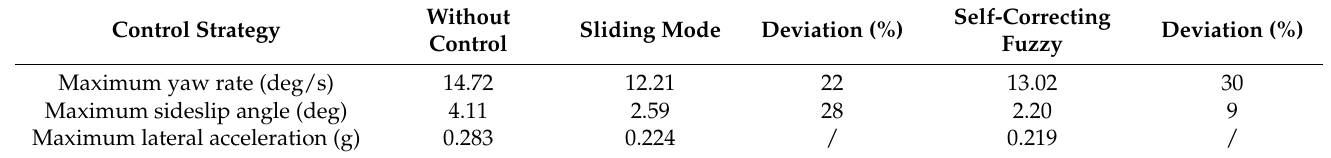
Table 5. The maximum values of the main control parameters under the double shift line condition.